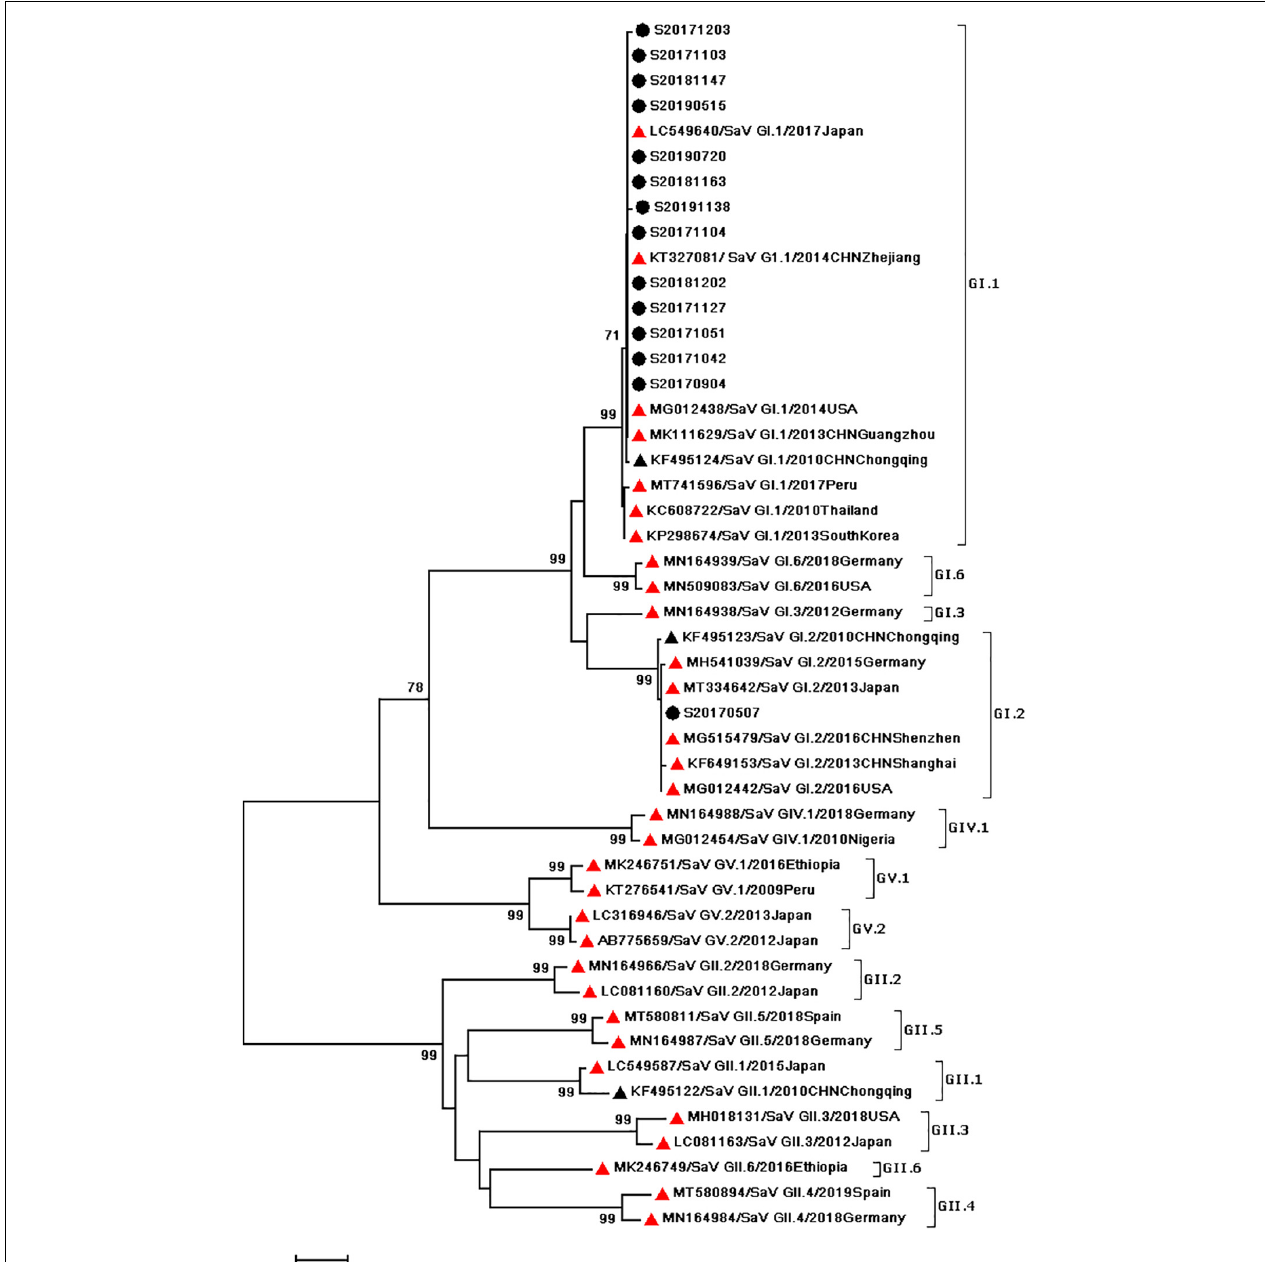
FIGURE 4 | Phylogenetic tree of SaV detected in Chongqing based on the 434bp–partial capsid sequence. The dendrogram was constructed by the maximum likelihood method with the Kimura two–parameter model in MEGA 7.0. Numbers at each node represents bootstrap values obtained with 1,000 replicates ( > 70 are shown). The scale bar represents the unit for the expected number of substitutions per site. Strains from the present (designed S/year/month/number) and previous(including accession number, genotype, year, and location) study are labeled with a black circle and black triangles. Red triangles indicate reference strains (including accession number, genotype, year, and